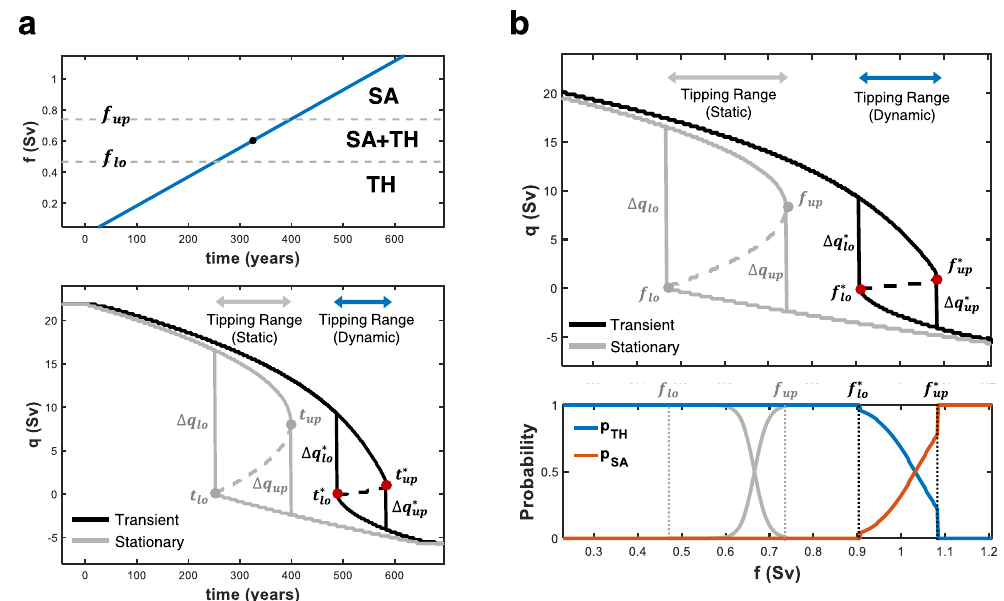
Fig. 2 Demonstration of tipping modulation under transient freshwater forcing using Stommel ’ s model. a In the upper panel, the prescribed freshwater fl ux forcing (FWF) is plotted. Tipping range boundaries at the stationary FWF ( f lo and f up ) are marked as a gray-dashed line. In the lower panel, the time evolution of PDF for transient FWF (black line) and stationary FWF (gray line) are plotted. The transient solution was obtained by solving the Fokker – Planck equation (Eq. (7)) with time-varying FWF. The stationary solution was calculated by the stationary PDF (Eqs. (8a) and (8b)) for the FWF value at each time step. The thick and dashed line denoted the local maximum and minimum of PDF, respectively. The time axis is dimensional and time is given in years. b In the upper panel, the result in ( a ) is replotted using f as the x -axis. In the lower panel, p TH (blue line) and p SA (orange line) for transient PDF are plotted. The result for stationary PDF was plotted as a gray line for